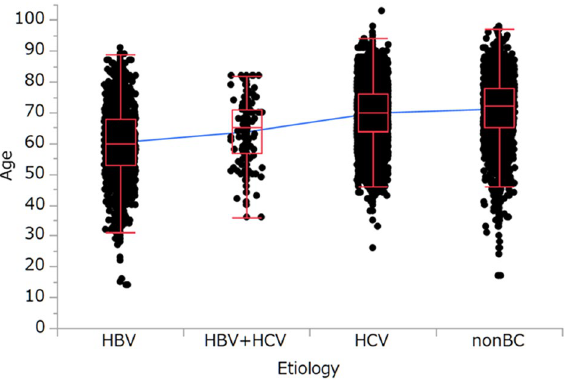
Figure 2. Correlation between patient age and disease etiology. 60.2 ± 10.9 years in HBV to 63.6 ± 10.0 years in HBV + HCV, P < 0.0001; 63.6 ± 10.0 years in HBV + HCV to 69.7 ± 8.8 years in HCV, P < 0.0001; 69.7 ± 8.8 years in HCV to 71.0 ± 9.9 years in non-BC, P < 0.0001, respectively (mean ± standard